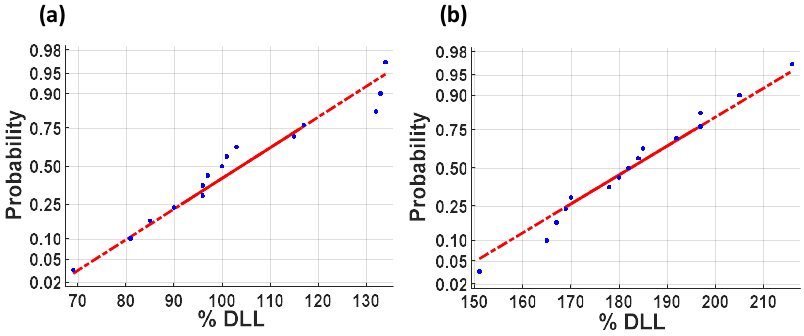
Figure 6. Data normality test for: ( a ) the load at first damage signal, and ( b ) the ultimate load datasets.